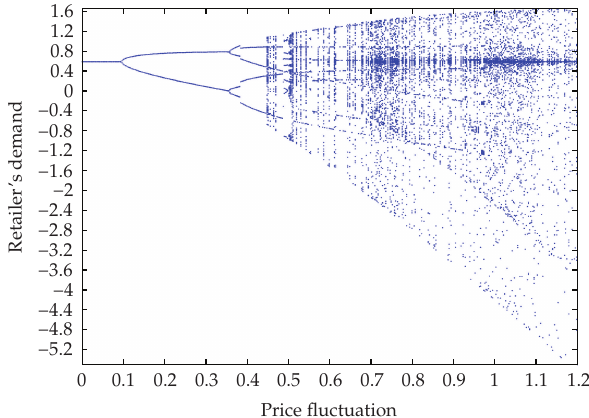
Figure 4: The bifurcation diagram of retail’s demand (cid:6) k (cid:9) 0.6, p (cid:9) 10 (cid:7) .